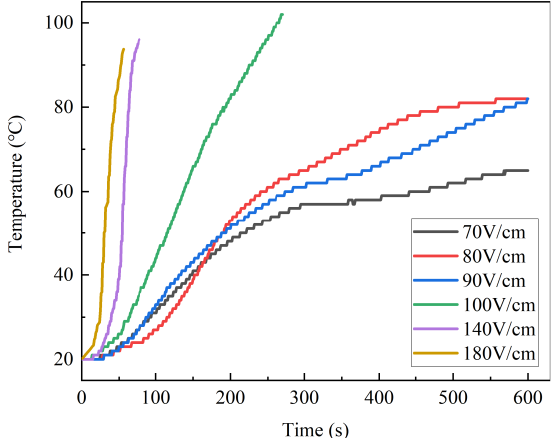
Figure 5. Temperature changes of the oil shale with time under different electric field intensities .